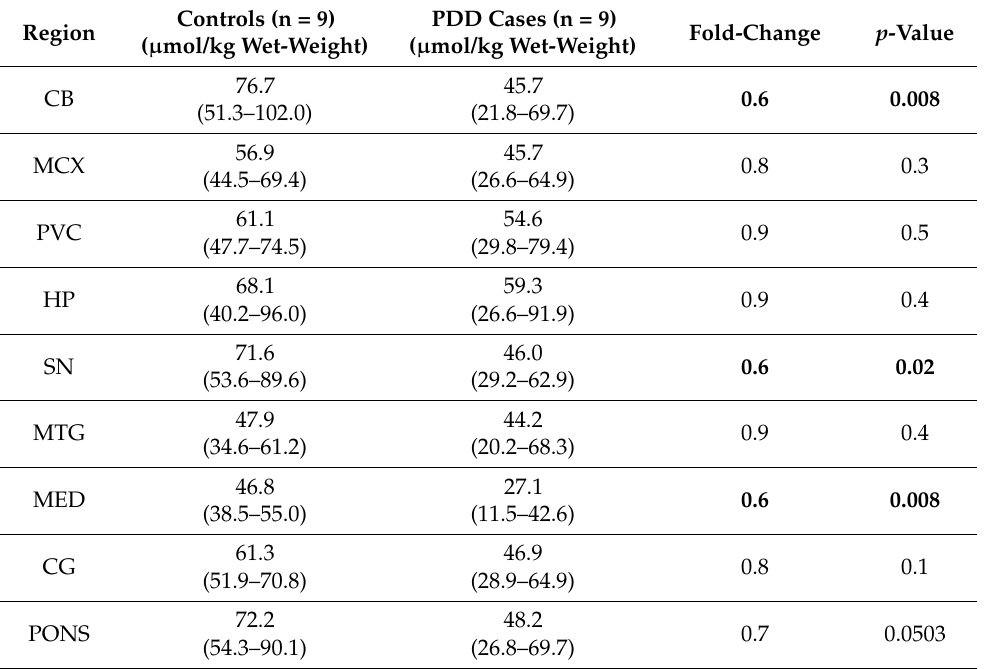
Table 2. Pantothenic Acid Concentrations in PDD Cases and